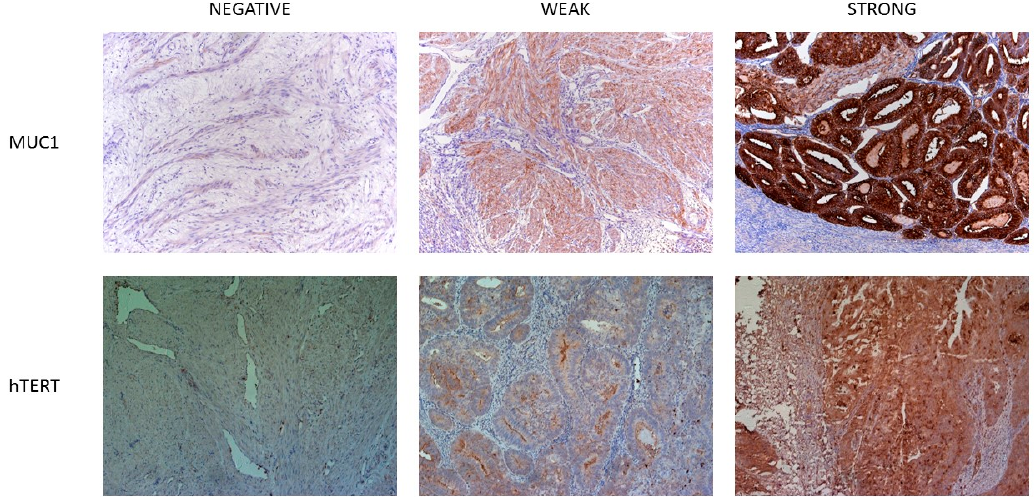
Figure 2. Immunohistochemical staining of MUC1 and hTERT in uterine cancer tissues. In this picture, we show a representative picture of a negative, weak and strong staining pattern for both antigens. Pictures were taken at a 10× magnification.